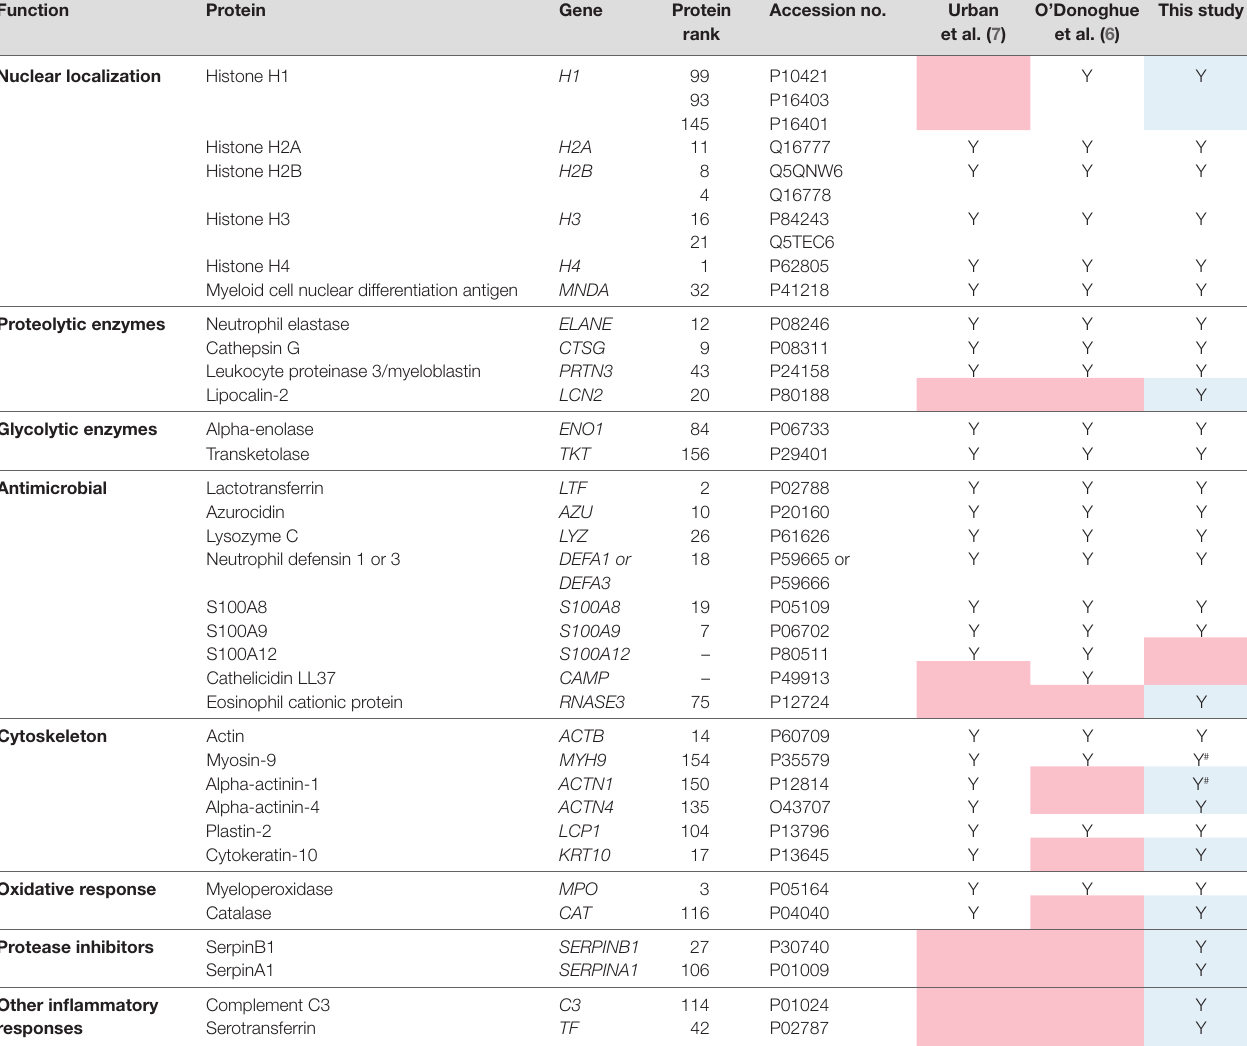
TaBle 1 | Comparison of neutrophil extracellular trap-associated proteins